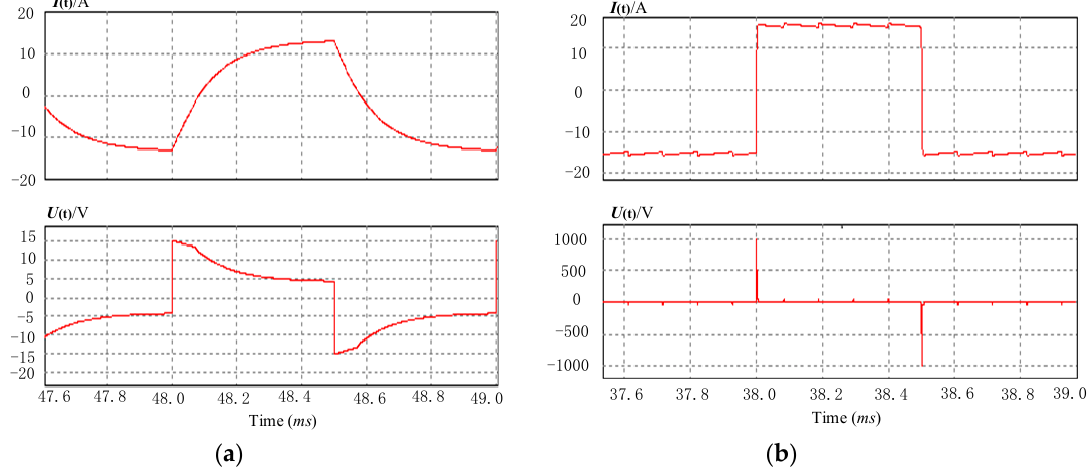
Figure 7. Waveforms of the output current and voltage, 1 KHz. ( a ) Traditional full-bridge circuit; ( b ) Constant current and voltage clamping control circuit.